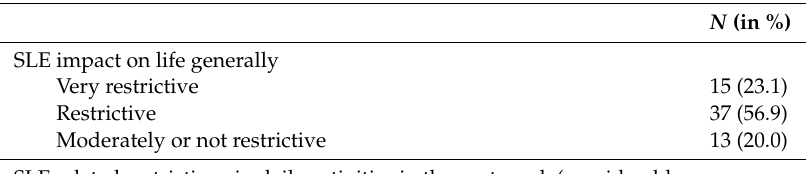
Table 4. SLE impact on patients’ lives (in %, N = 67).